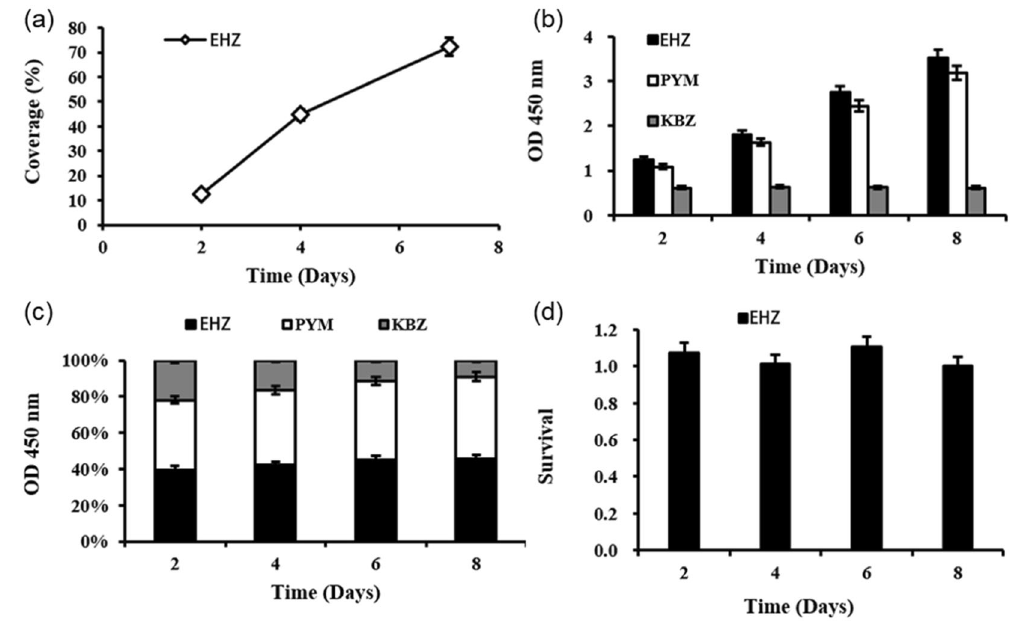
Fig. 9 Statistical analysis of HUVEC growth on the bioarti fi cial blood vessel: a Cell coverage of the bioarti fi cial blood vessel, EHZ repre- sents the cross-linked group. b OD values from CCK-8 test, PYM